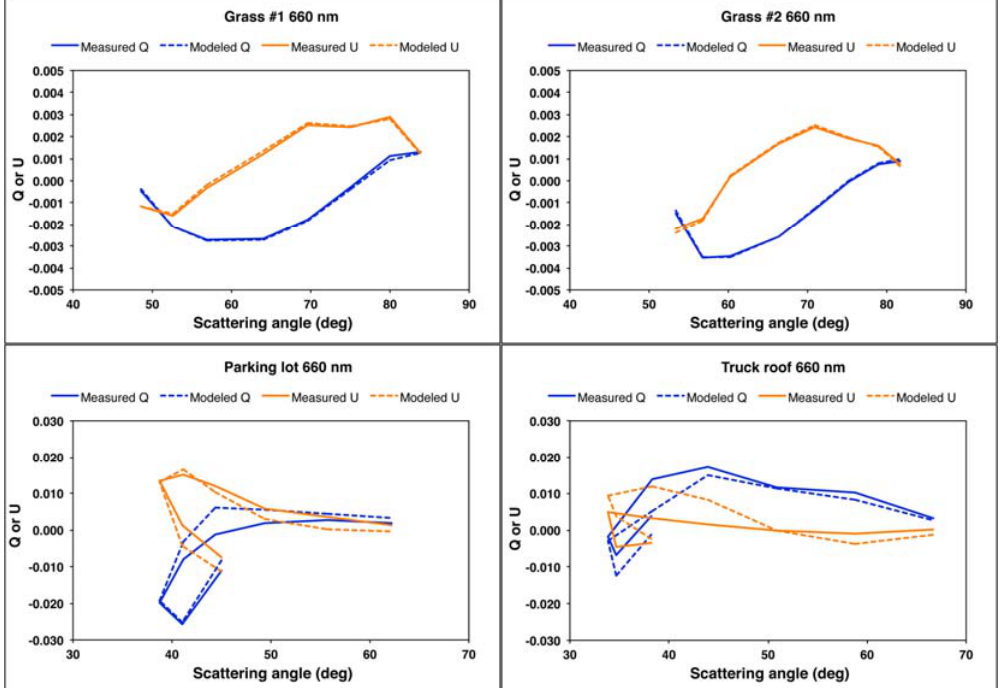
Figure 12. Similar to Figure 7, but with the modeled Q and U obtained from I